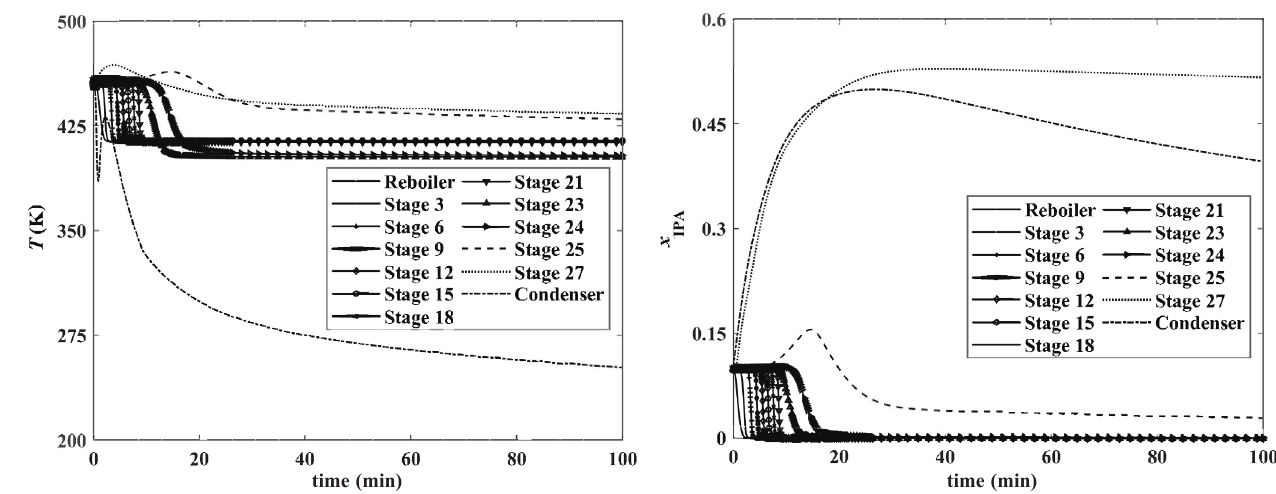
time (min)time Fig. 5 – Profiles of IPA mole fraction in ideal stages of the column with respect to time